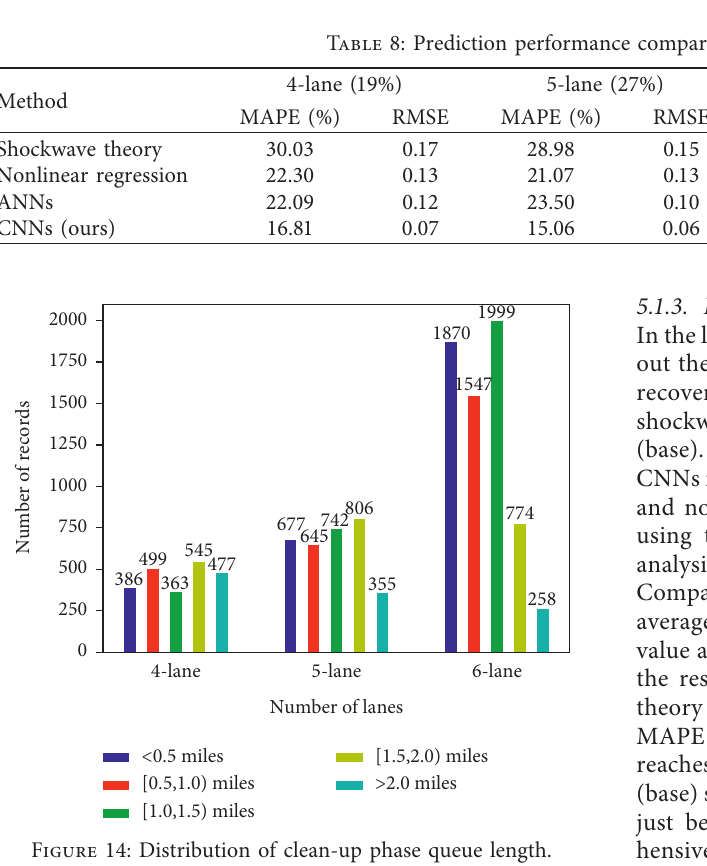
Figure 14: Distribution of clean-up phase queue length.